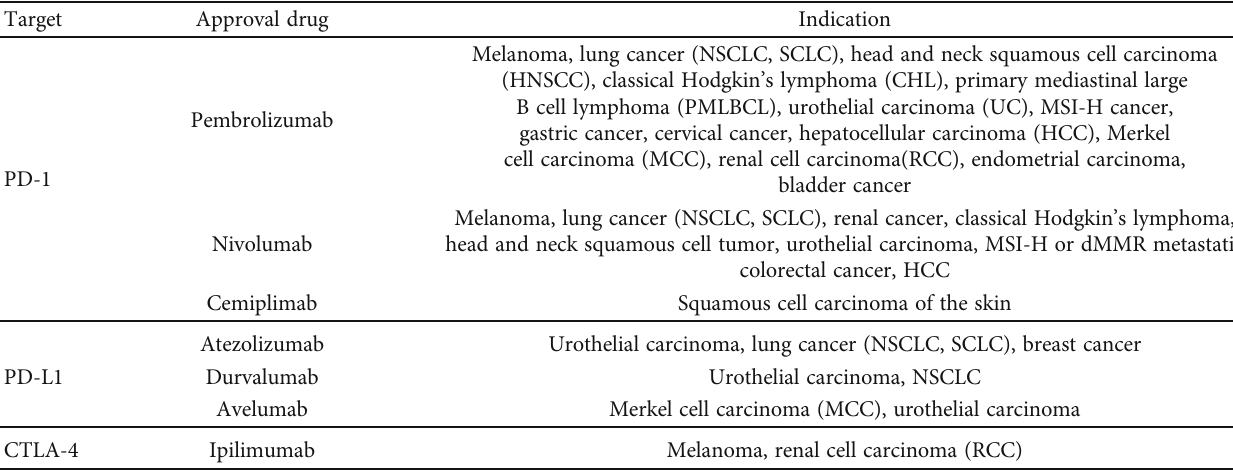
Table 1: FDA-approved immune checkpoint blocking